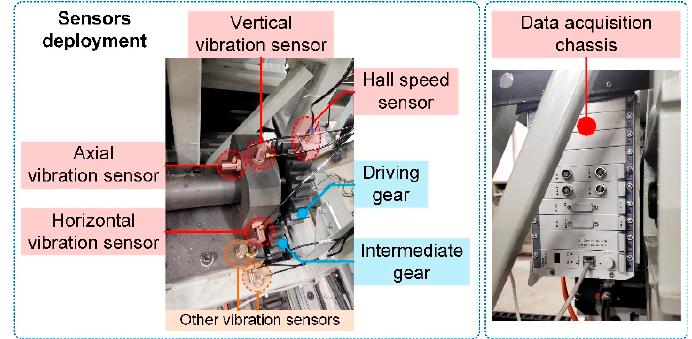
Figure 19. Driving gear in battery swapping system.